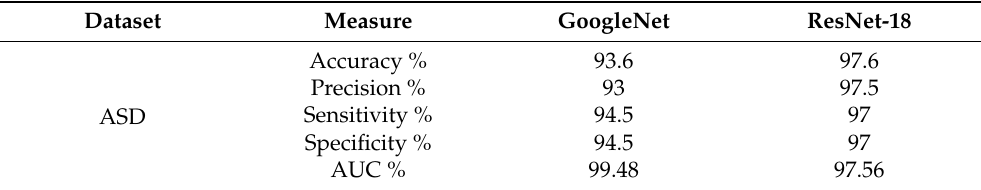
Table 7. Performance of GoogleNet and ResNet-18 models on ASD dataset.